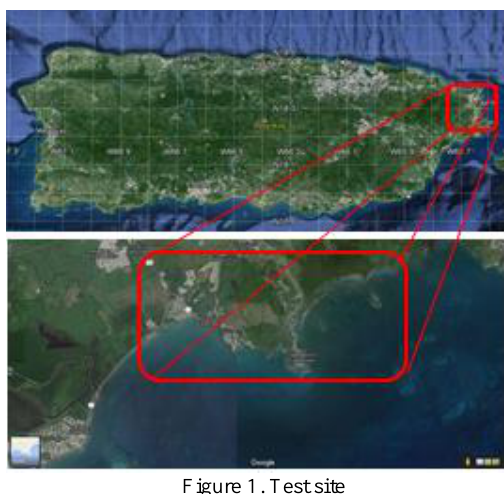
Figure 1. Test site